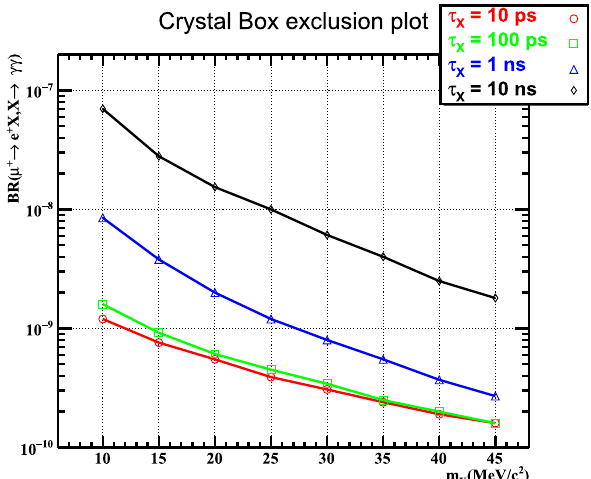
Fig. 1 Upper limits on MEx2G decay estimated by converting the upper limits on μ + → e + γγ from the Crystal Box experiment as a function of m X . Lines with different markers and colours correspond to different τ X from muon decays, the only kinematically allowed visible decay channels are X → e + e − and X → γγ . The former can occur at tree level while the latter can occur via a fermion loop. The current upper limit on μ + → e + X , X → e + e − (cid:3) (cid:2) [28] give stringent constraints on the at a level of O 10 − 12 MEx2G decay if we assume that X is more likely to decay into an e + e − pair. However, there is a possibility for X to be electrophobic,aspointedoutin[29,30],andsearchesforboth decay modes can hint at the model behind these decay modes. The current upper limit on the decay μ + → e + γγ , B ( μ + → e + γγ ) < 7 . 2 × 10 − 11 (90% C.L.) from the